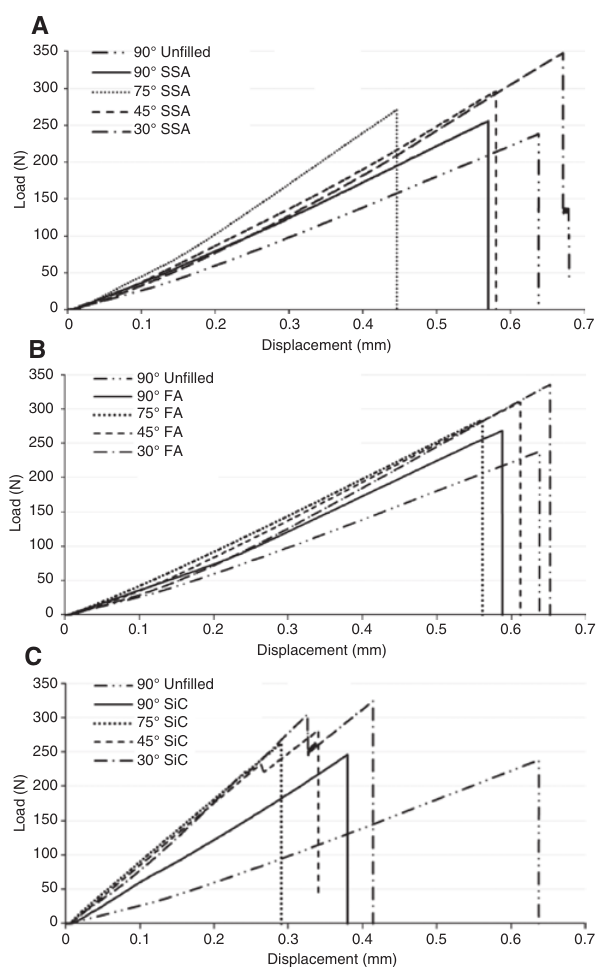
Figure 5: Load-displacement curves for SENB specimens having dif- ferent crack inclination angles at content of 5 wt% (A) SSA, (B) FA, and (C) SiC.